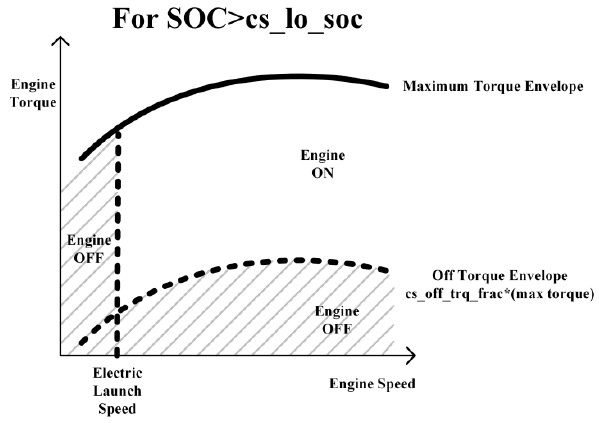
/ control variables Figure A1. Engine operation/control variables relationships. Figure A1. Engine operation